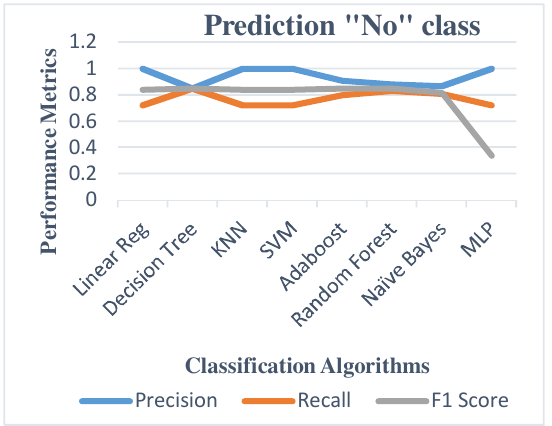
Fig. 5: Performance Matric for No Class from 0 to 1. The value will be 1 when the system performs